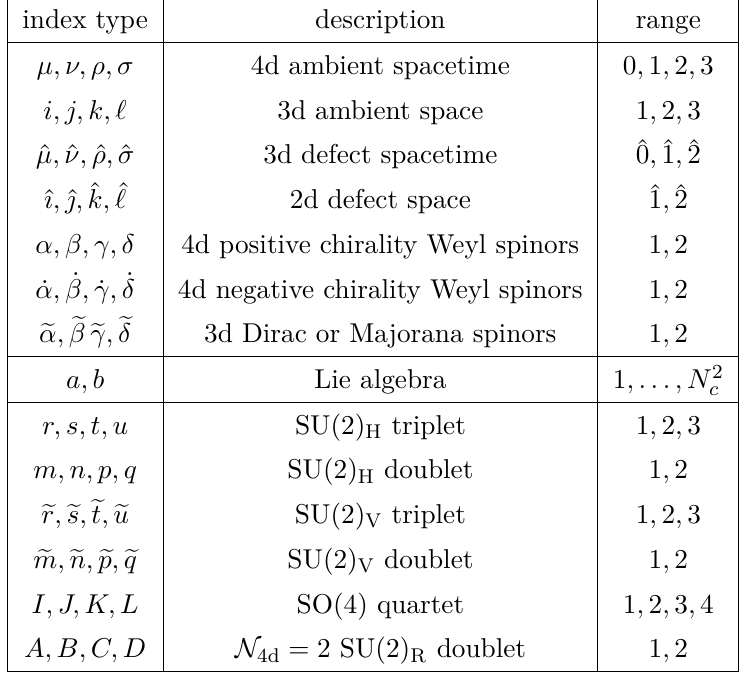
Table 1 . Summary of index conventions and ranges. Note that indices on 4d Dirac and Majorana spinors are always